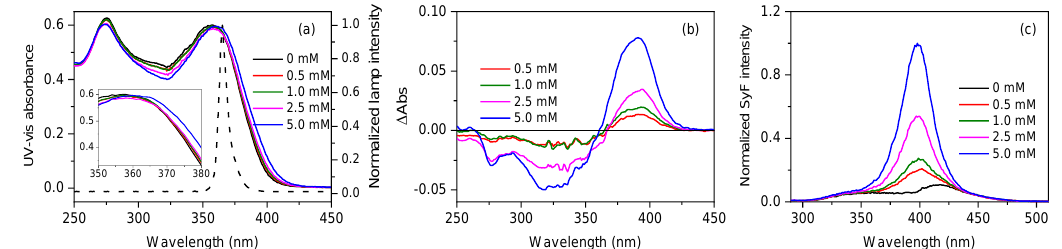
Figure 3. UV-Vis absorbance ( a ), changes in UV-Vis absorbance ( b ) and normalized (to highest peak) synchronous fluorescence (SyF) spectra ( c ) of TC with increasing Ca(II) concentrations.